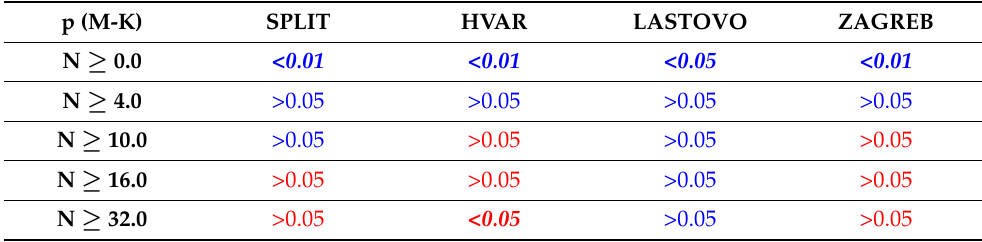
Table 5. Matrix with the results of the probability of the Mann–Kendall test, p